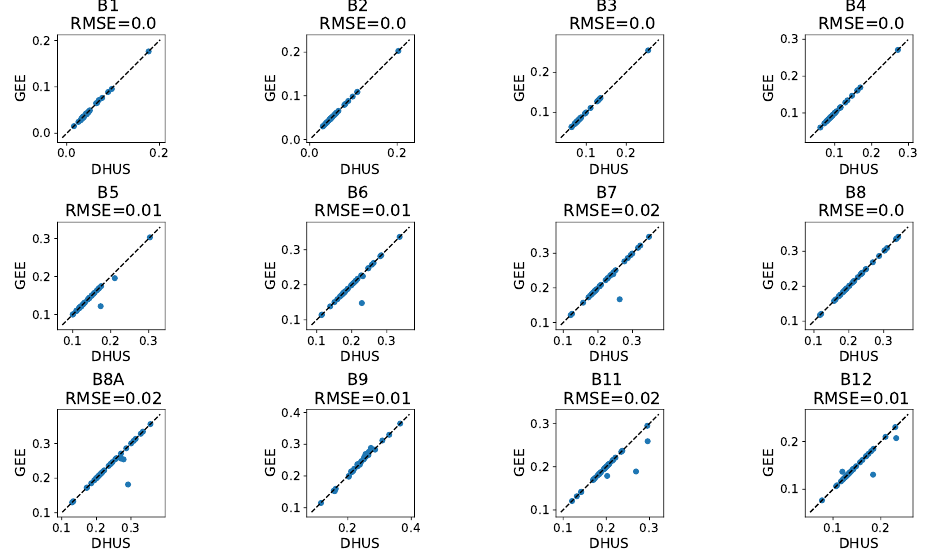
Figure A2. Sentinel-2 level-2 [62] single-pixel reflectance time-series from GEE ( y -axis [63]) and DHUS ( x -axis [54]) datasets, both resampled to 20 m. In spite of the outliers in bands with native 20 m resolution (B5, B6, B7, B8a, B11, B12), probably caused by GEE pixel weighting during the resam- pling [67], all pixels demonstrate the expected behavior. The nearest pixel to the Sudan agricultural field site (14.40551 ◦ N, 33.39137 ◦ E) for the period from 1 July 2019 to 31 March 2020 (54